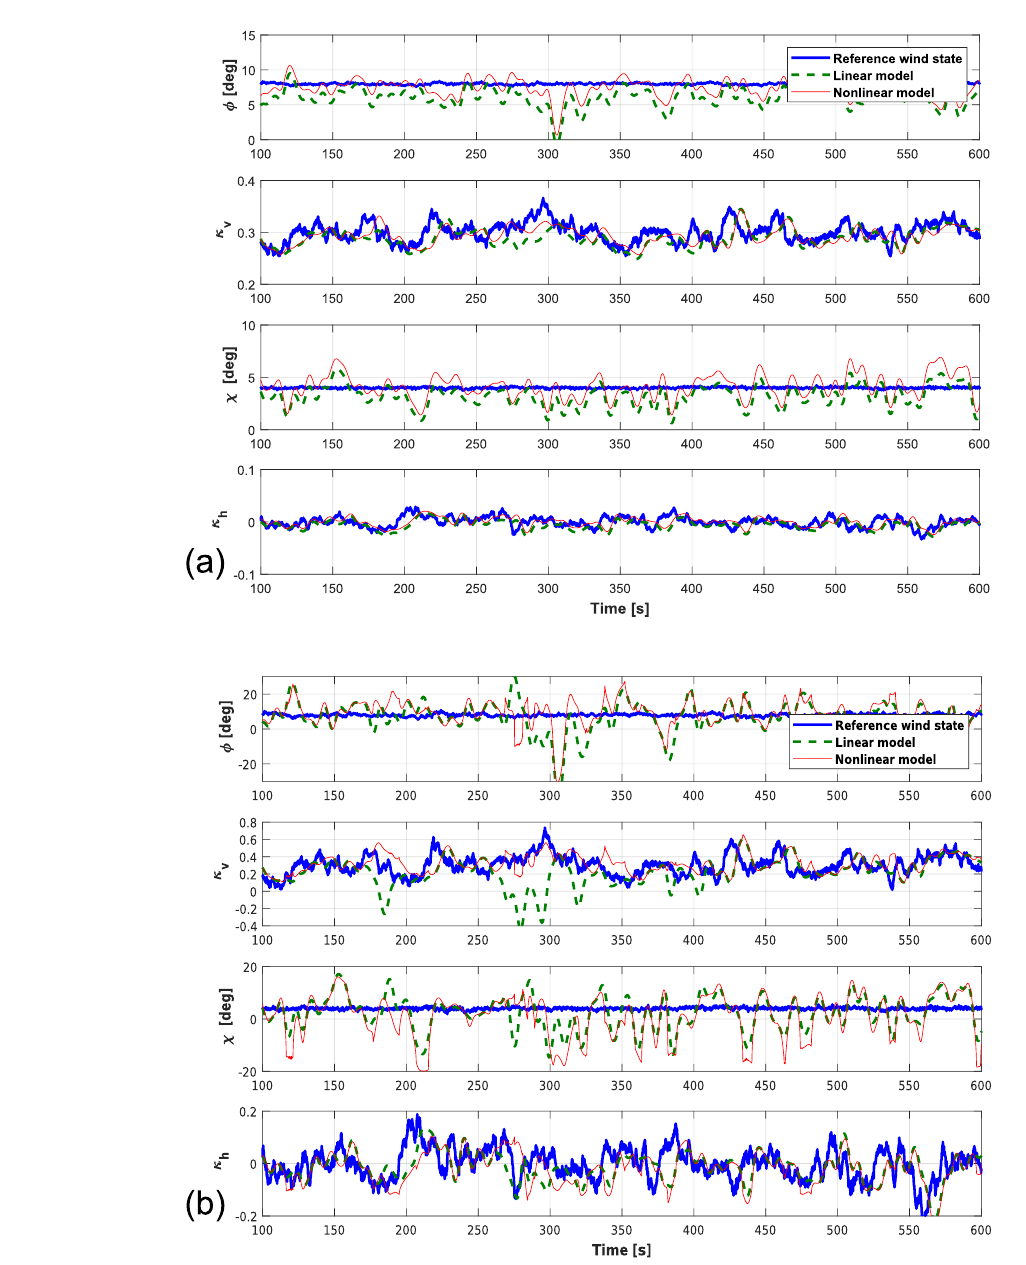
Figure 13. Wind state observations in turbulent wind conditions at 19ms − 1 for a TI equal to 2 (a) and 12% (b) . Solid thick blue lines: reference wind parameters; dashed thick green lines: observations by the linear model; solid thin red lines: observations by the nonlinear